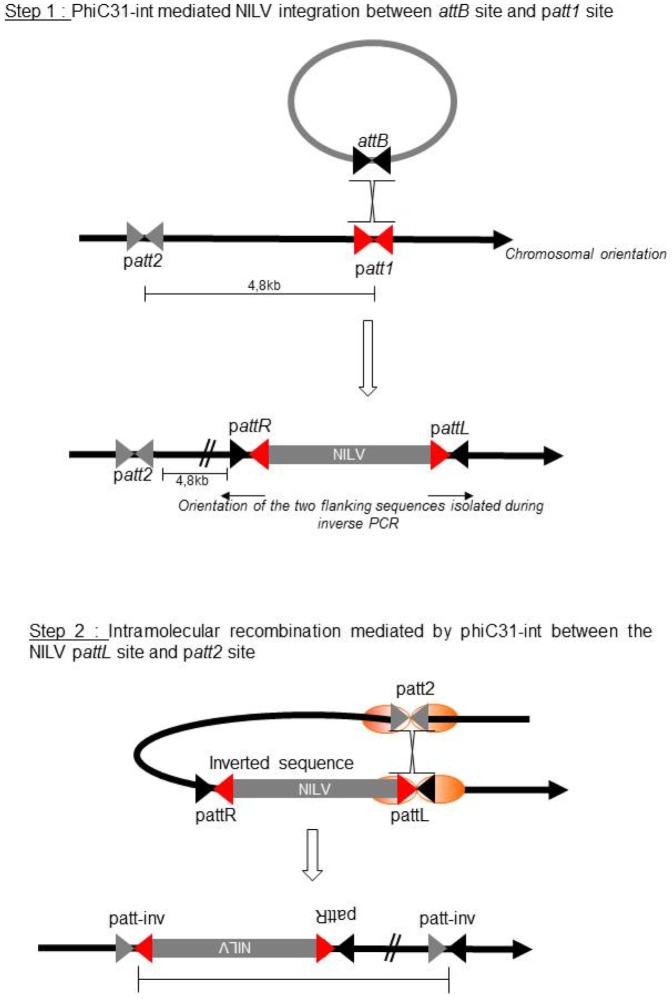
Hypothetical model to explain the inversion of 4.8Step 1: Integration of a NILV mediated by phiC31-int into a pattP site. Step2: Recombination mediated by phiC31-int between the pattL generated during step 1 and another patt site located at 4 kb.